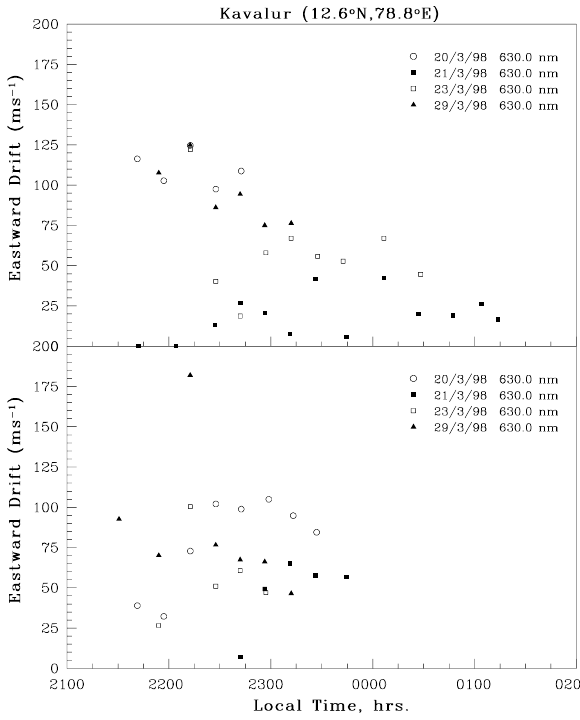
Fig. 9. Eastward drift velocity of plasma depletions over Kavalur during nights of 20/21, 21/22, 23/24 and 29/30 March 1998. Top and bottom panels show velocities of two different depletions ob- served on the same